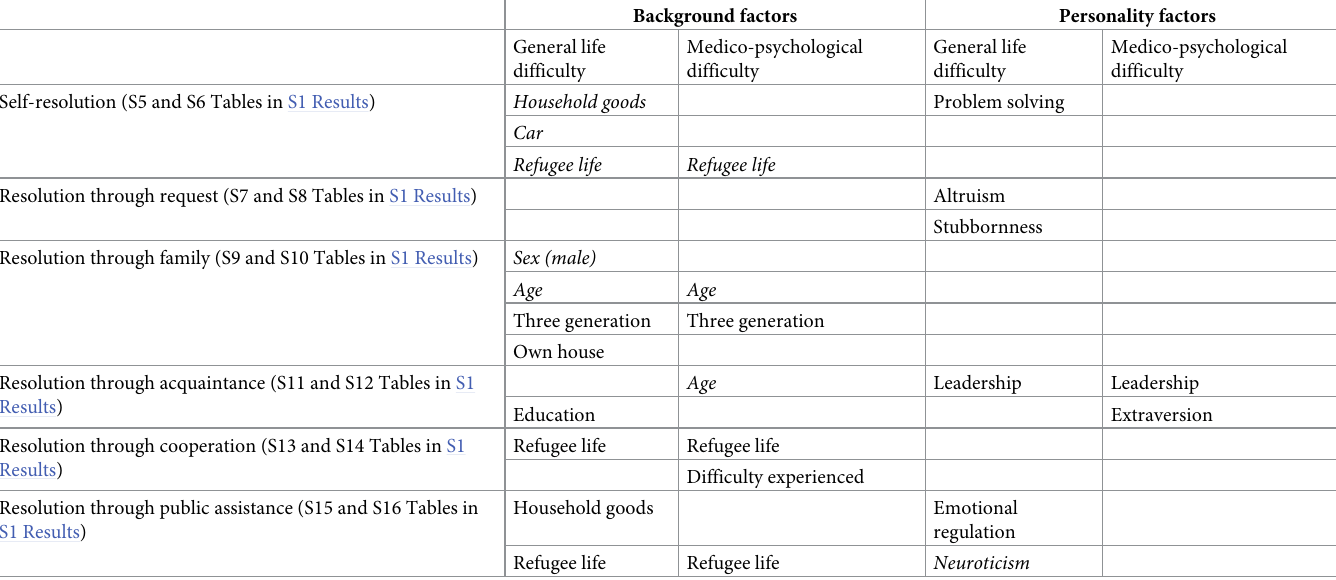
Table 3. Facilitative factors for six resolution